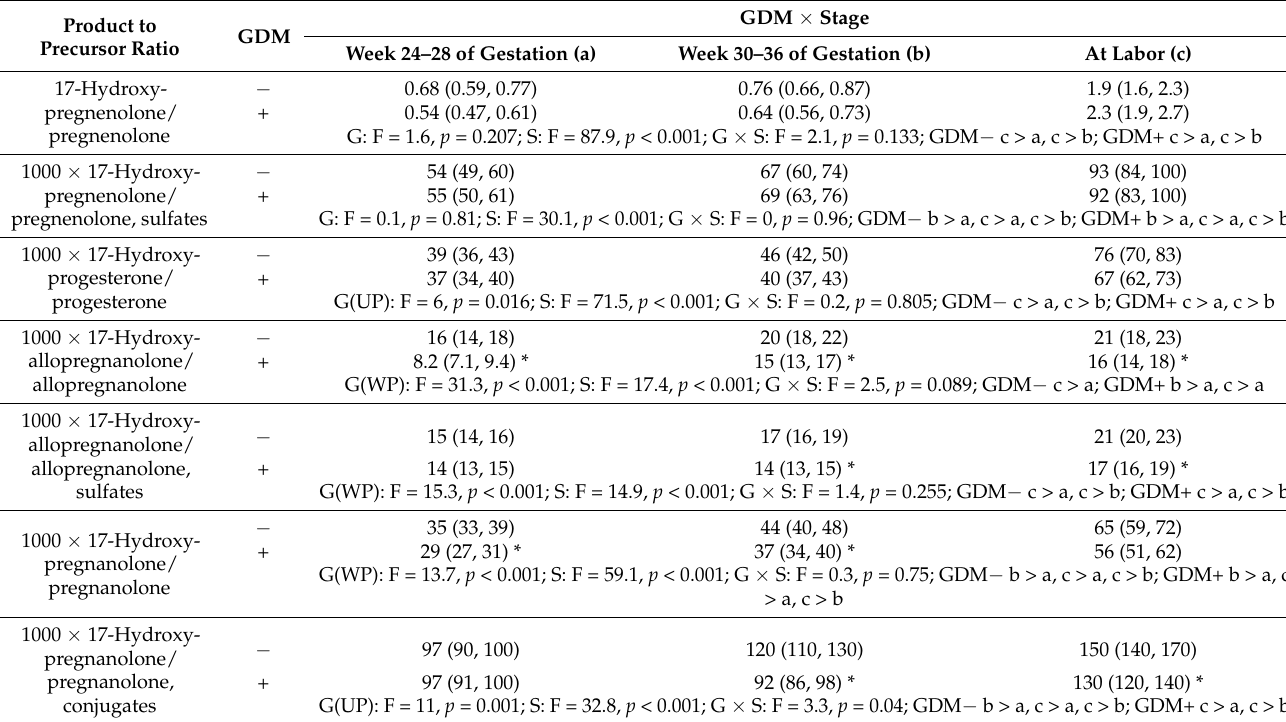
Table 2. Profiles of product to precursor ratios that may reflect the balance between 17-hydroxy-steroids and corresponding 17-deoxy-steroids and possibly also the activity of CYP17A1 (17-hydroxylase step) in the GDM − and GDM+ groups from week 24 of gestation to